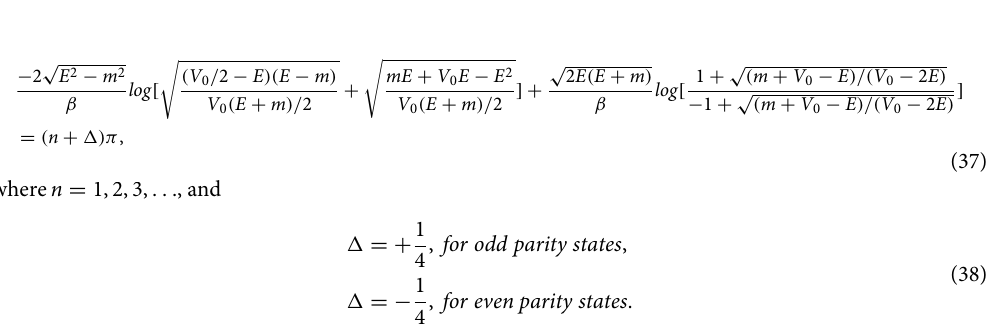
Figure 4. The bound state (BIC) energy of exponential potential. The solid lines are the the exact results of Eqs. (33), (35), and (36) . The black dashed lines are given by the quasi-classical approximation formula Eq. (37). m . We note that there also exist some conventional bound states in the Here we take β =